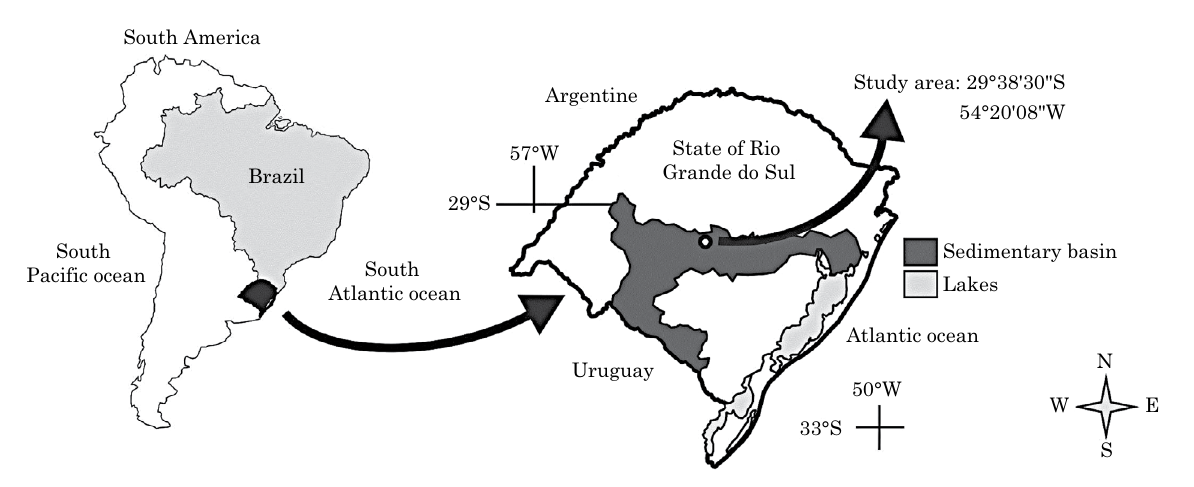
figure 1. Localization of the study